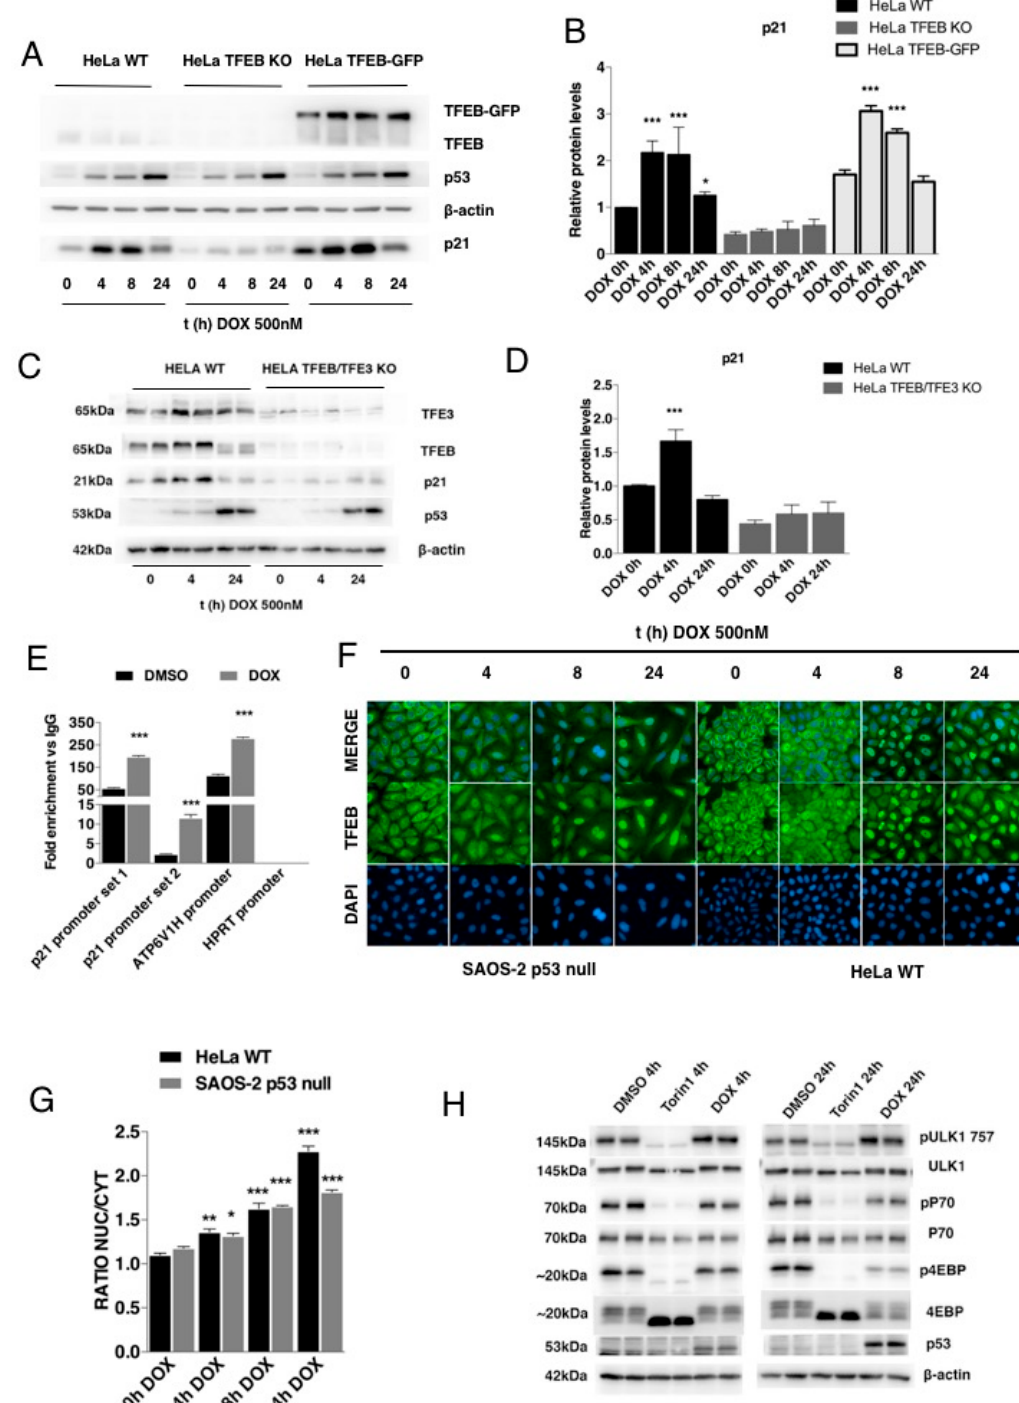
Figure 3. p21 upregulation in response to DNA damage requires TFEB activation. ( A ) Western blot analysis of the protein content of p21, p53, and TFEB in HeLa WT, TFEB KO, and TFEB-GFP after treatment with doxorubicin (DOX) at 0.5 µM for 0–24 h. β -actin protein levels were used as loading control. ( B ) Quantification of p21 protein levels in HeLa WT, TFEB KO, and TFEB-GFP after treatment with doxorubicin (DOX) at 0.5 µM for 0–24 h. ( C ) Western blot analysis of the protein content of p21, p53, TFE3, and TFEB in HeLa WT, TFEB/TFE3 KO after treatment with doxorubicin (DOX) at 0.5 µM for 0–24 h. β -actin protein levels were used as a loading control. ( D ) Quantification of p21 protein levels in HeLa WT, TFEB/TFE3 KO after a treatment with doxorubicin (DOX) at 0.5 µM for 0–24 h. ( E )